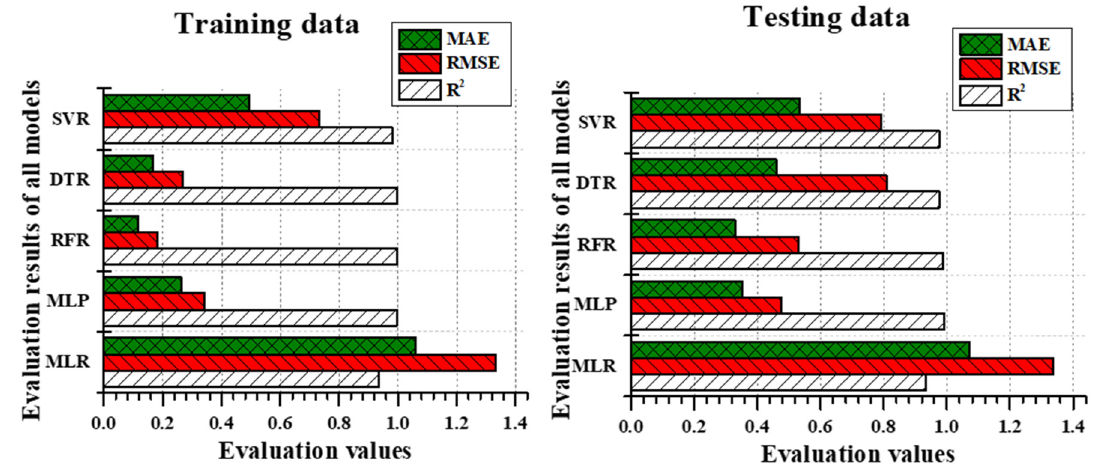
Figure 6. Training evaluation metric comparison between MLR, MLP, RFR, DTR, and SVR with S3 and testing evaluation metric comparison between those models during IAT prediction.